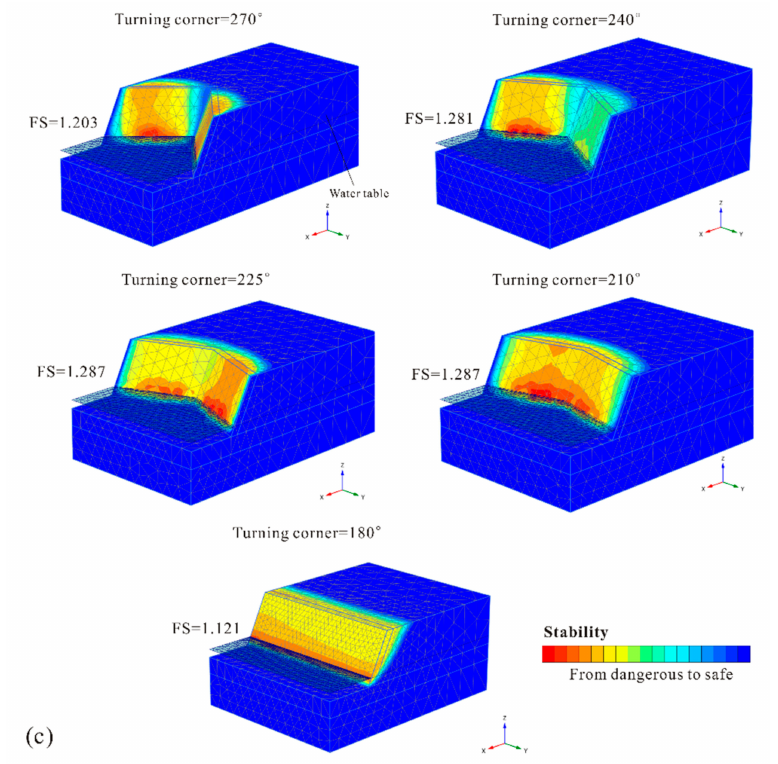
Figure 8. The failure mechanism of concave-shaped slopes with di ff erent corner angles: ( a ) gentle slope gradient of 1:2; ( b ) steep slope gradient of 1:1 and ( c ) very steep slope gradient of